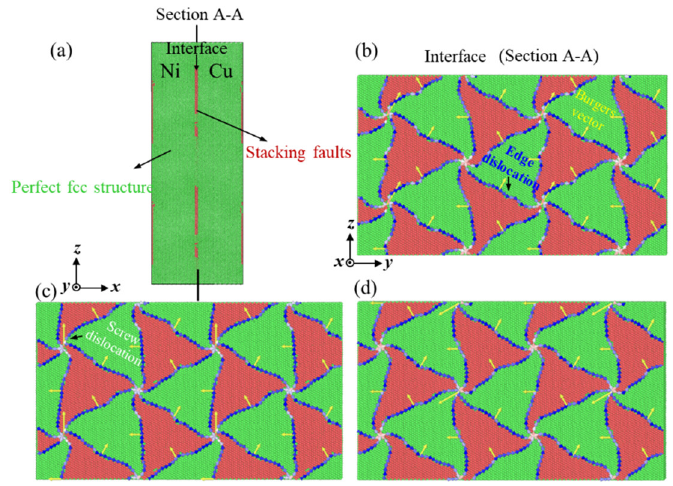
Figure 10. Configurations of Cu/Ni clad foil with semi-coherent: ( a ) CNA analysis results, DXA analysis results, ( b ) annealed at 600 °C, ( c ) annealed at 700 °C, ( d ) annealed 850 °C.